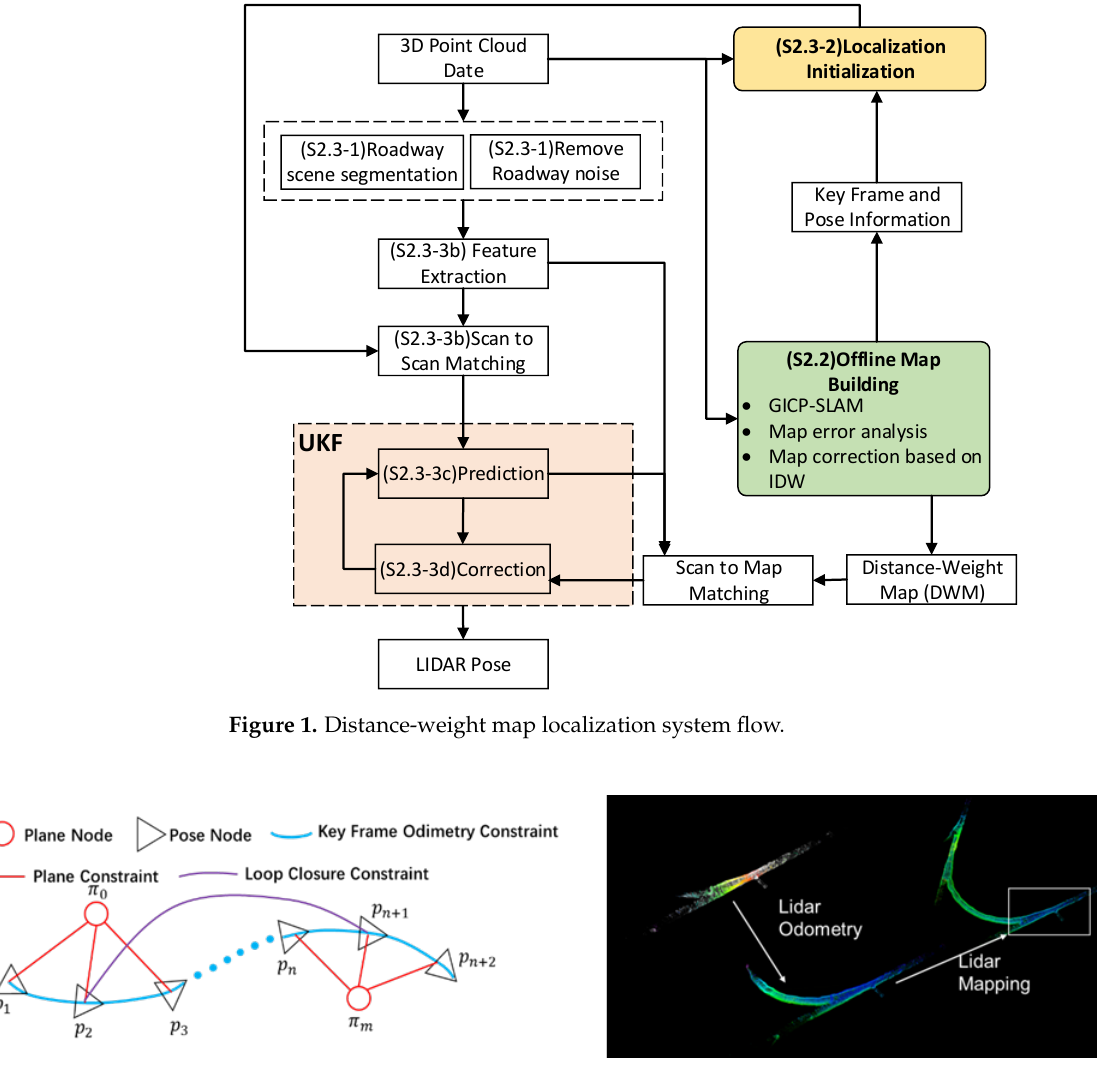
Figure 2. Graph optimization and point cloud map construction diagram. {𝑝 1 , 𝑝 2 ,. . . 𝑝 𝑛+2 } is the key frame pose node, and {𝜋 0 ,𝜋 1 ,. . . 𝜋 𝑛 } is the extracted roadway ground plane coefficient node.